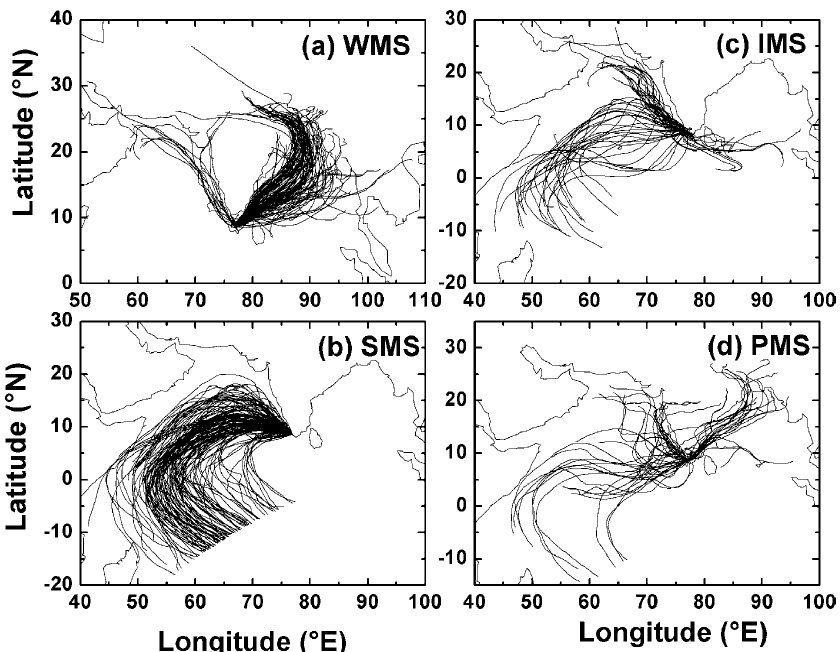
Fig. 8. Mass plots of the trajectories (arriving at 500m a.g.l. (above ground level) at TVM) for each season. In the figure, panels (a) and (b) show the contrasting seasons WMS (December through March) and SMS (June through September), while (c) and (d) shows the periods of transition, IMS (April and May) and PMS (October and November).